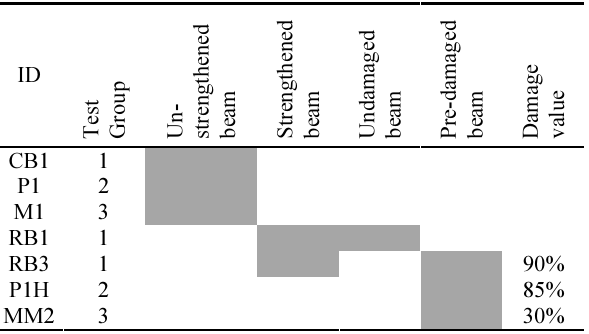
Table 2. Strengthening schemes of test